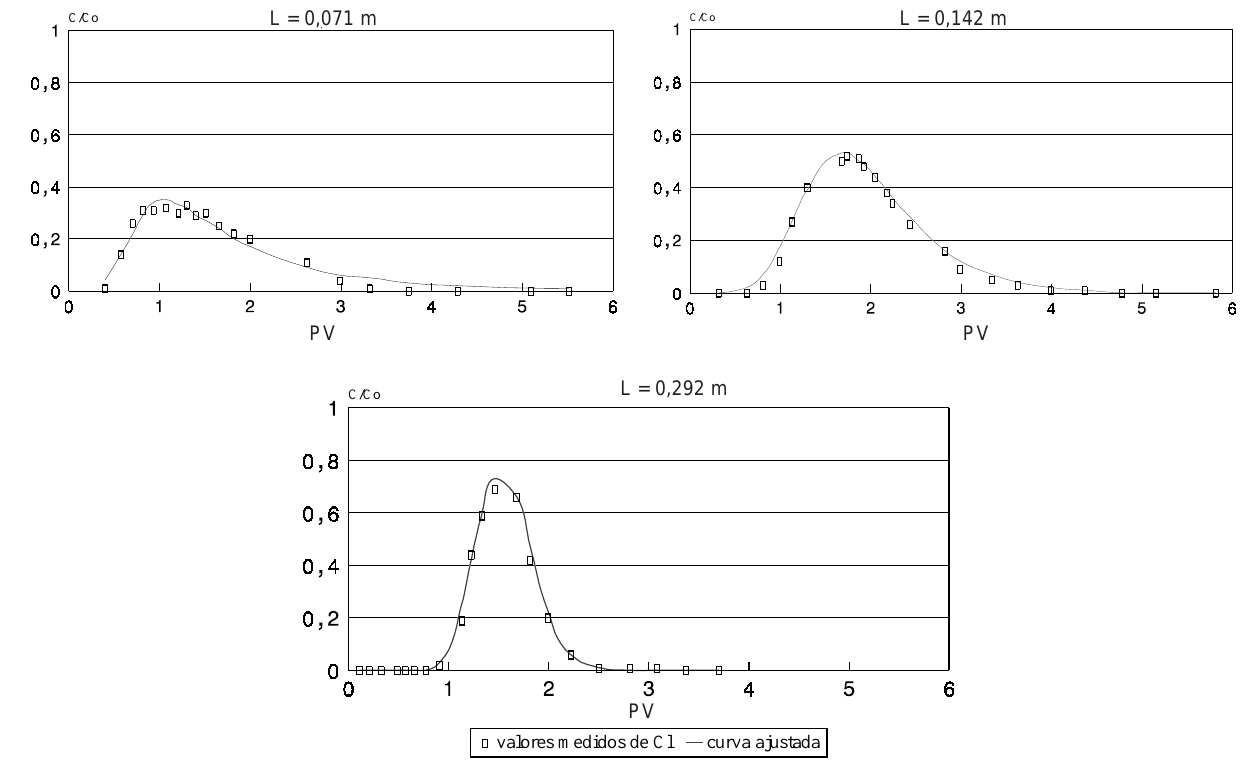
valores medidos de Cl curva Figura 1. Efeito do comprimento de coluna sobre a forma da BTC. Algumas características da situação experimental criada e dos parâmetros de transporte calculados podem ser verificados no quadro 1 (C/Co = concentração relativa do marcador no efluente; PV = volume de poros eluídos).